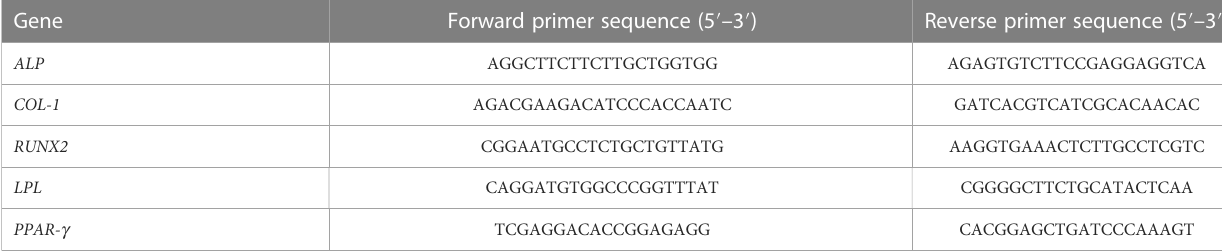
TABLE 1 Primers used for RT-qPCR. Gene Forward primer sequence (5 ′ – 3 ′